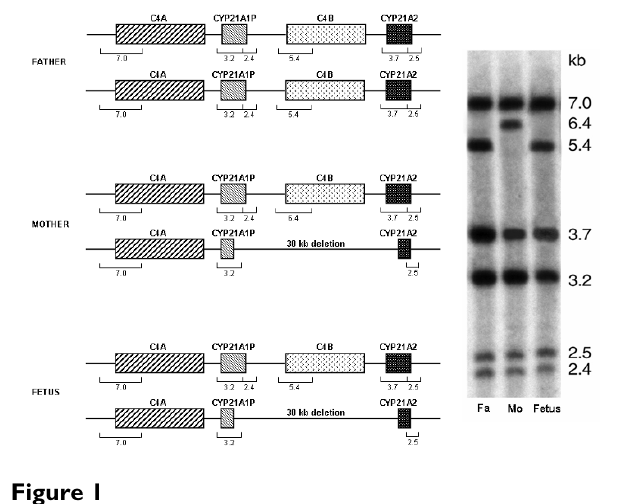
Southern blot analysis . Taq I restriction patterns of genomic DNA hybridized to a mixture of the CYP21A2 and C4 cDNA probes. Fa: father, Mo: mother. For pattern analy- sis see the text in results